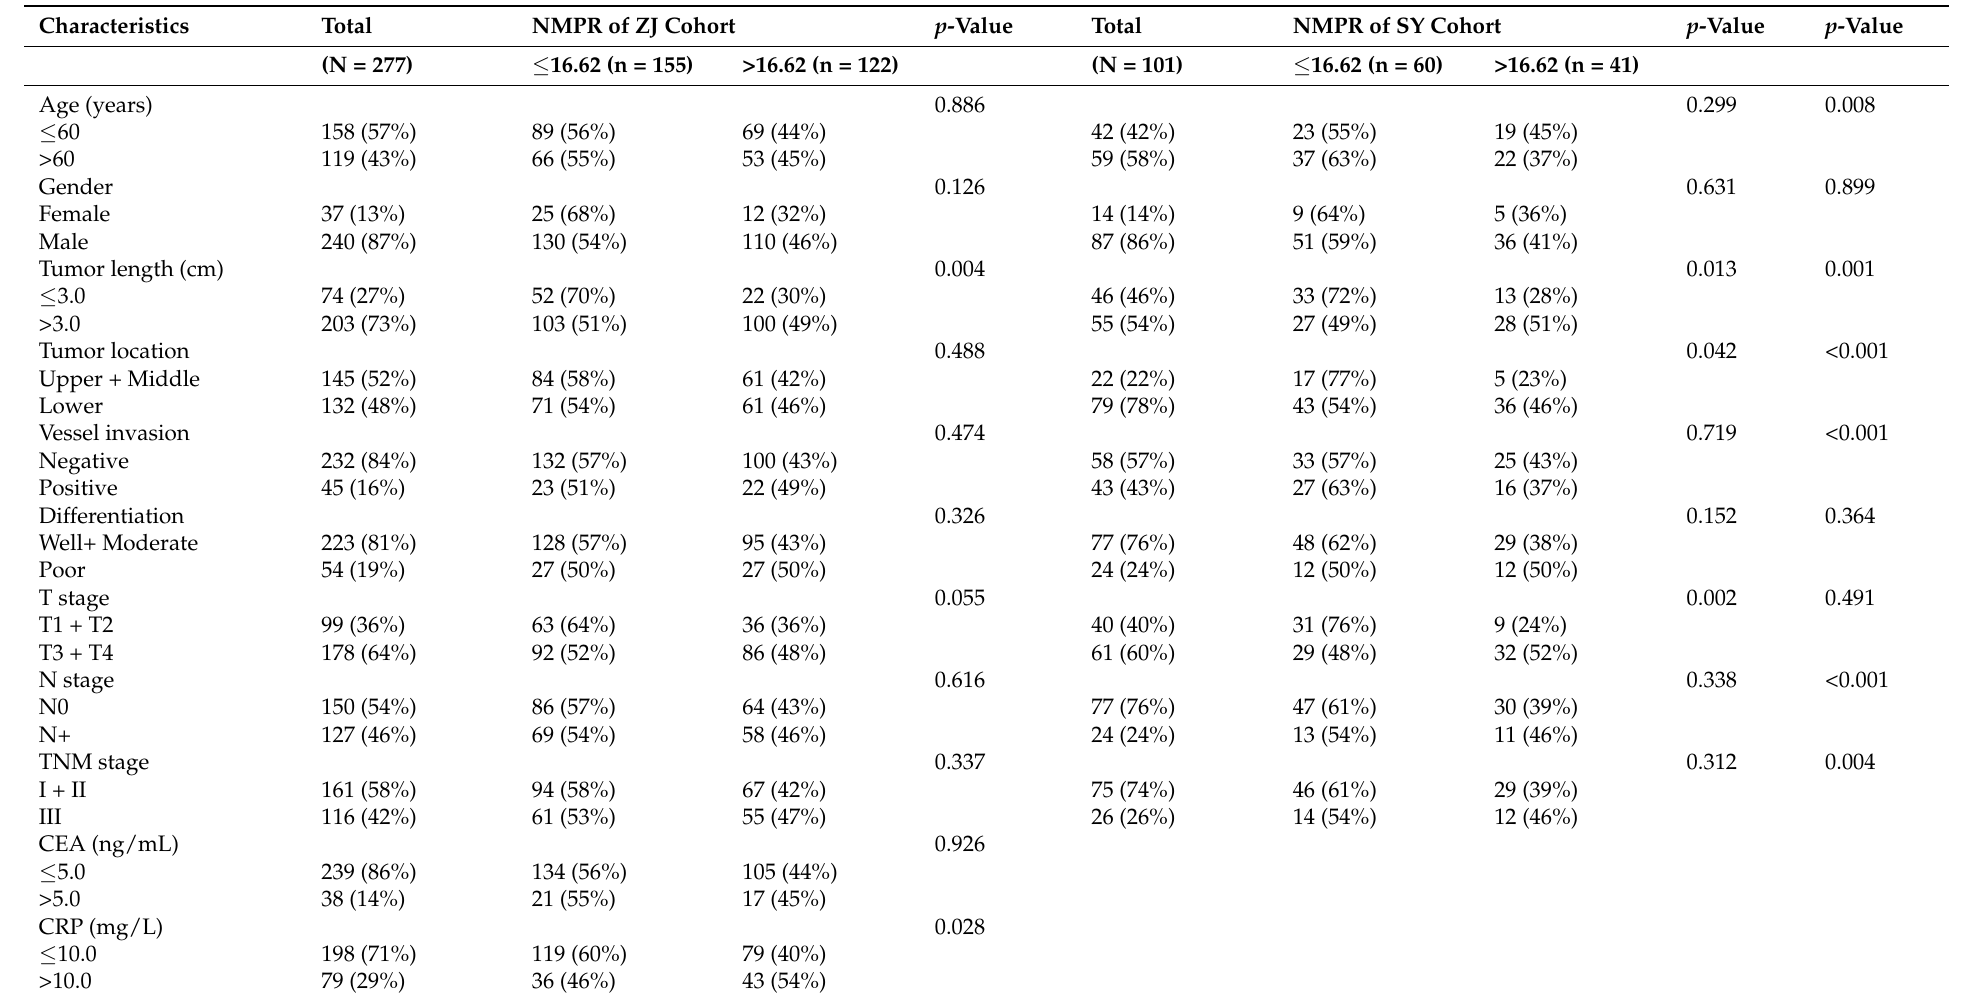
Table 1. Baseline characteristics of the training cohort (ZJ Cohort) and external validation cohort (SY cohort) according to NMPR